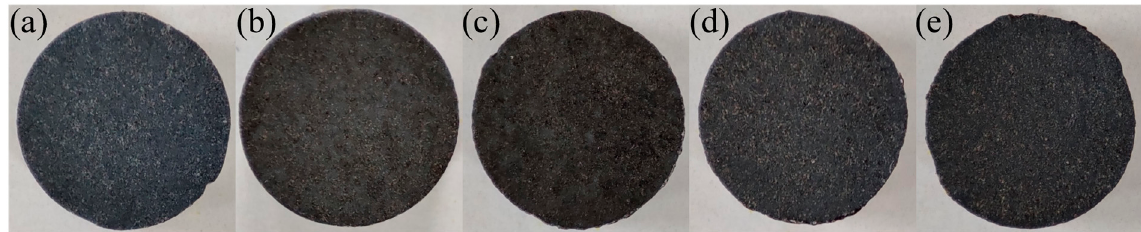
Figure 1. Macro images of prepared samples: ( a ) reference sample, ( b ) Ni I, ( c ) Ni II, ( d ) Cu I, ( e ) Cu II; sample diameter—1 cm.